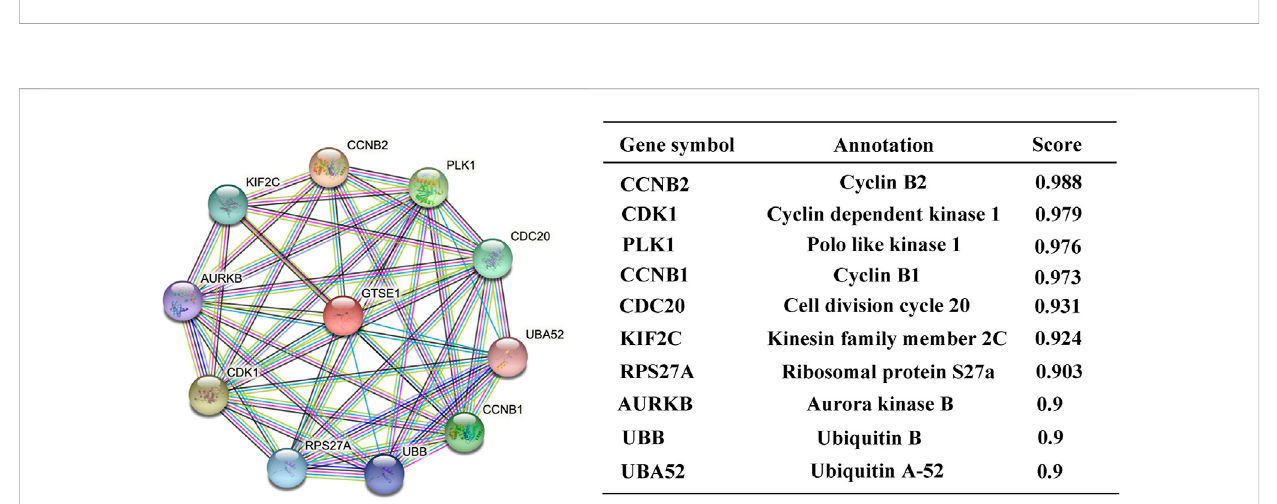
FIGURE 4 Constructing protein interaction networks. PPI network of GTSE1 and the top 10 proteins interacting with GTSE1. Annotation of GTSE1-interaction proteins and their con fi dence scores.